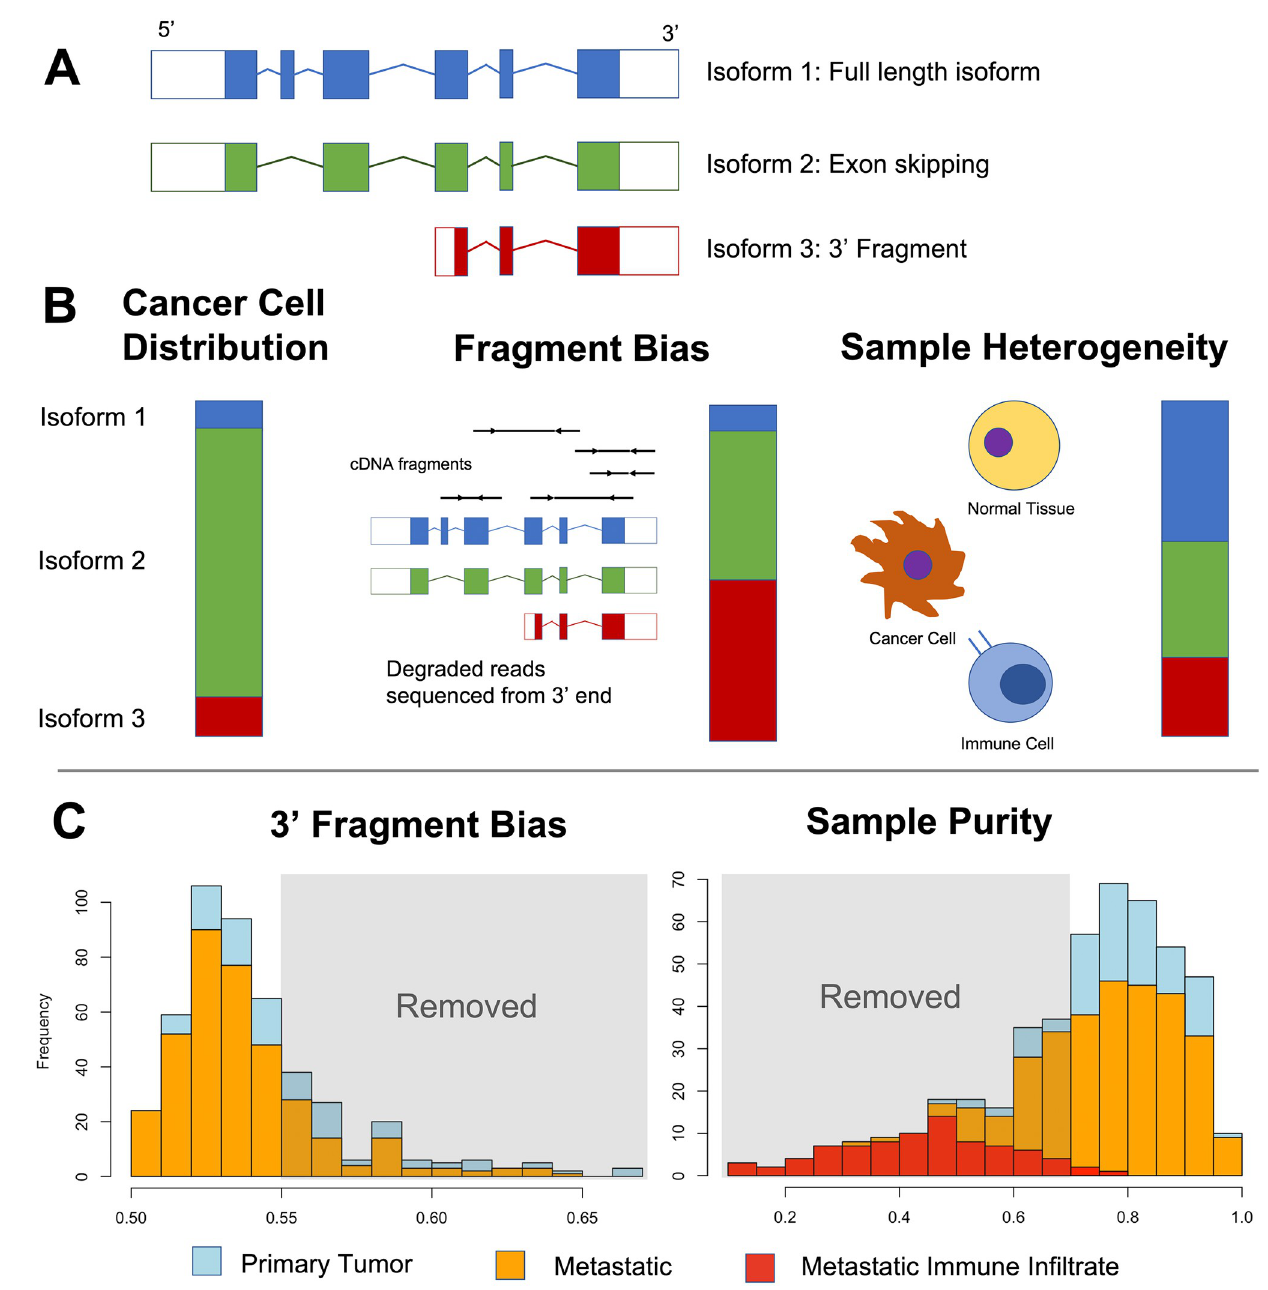
Fig 3. Examining data bias in isoform count estimation. (A) Isoform examples. (B) Cancer cell isoform distributions can be altered by effects of fragment bias and cell type heterogeneity (i.e. sample impurity). The bars represent the apparent relative expression level of each isoform, with the left bar indicating the true distribution in a cancer cell and the right two bars indicating how data bias can skew the results. (C) Primary and metastatic tumor samples assessed for 3’ fragment bias using QoRTs, where samples scoring above 0.55 were removed, and sample impurity, where samples with < 70% purity were removed. Red bars in the sample purity assessment indicate metastatic samples with observed high immune